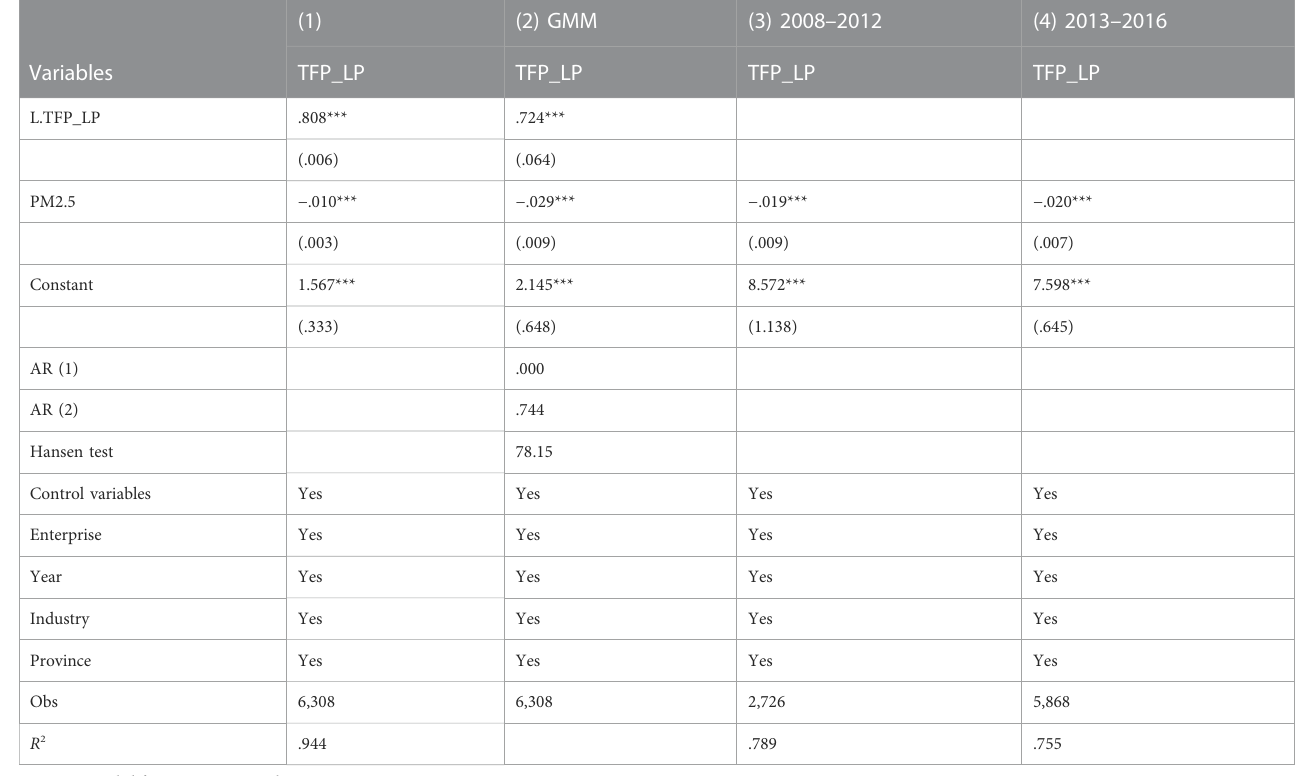
TABLE 4 Robustness